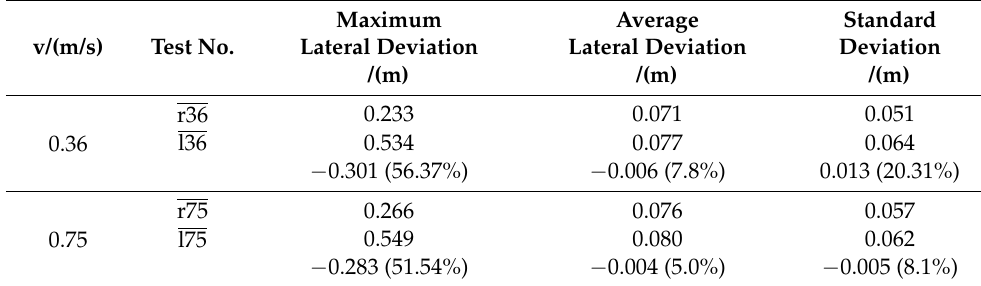
Table 7. Comparison of ‘U’-shaped path-tracking accuracy. v/(m/s) Test No.